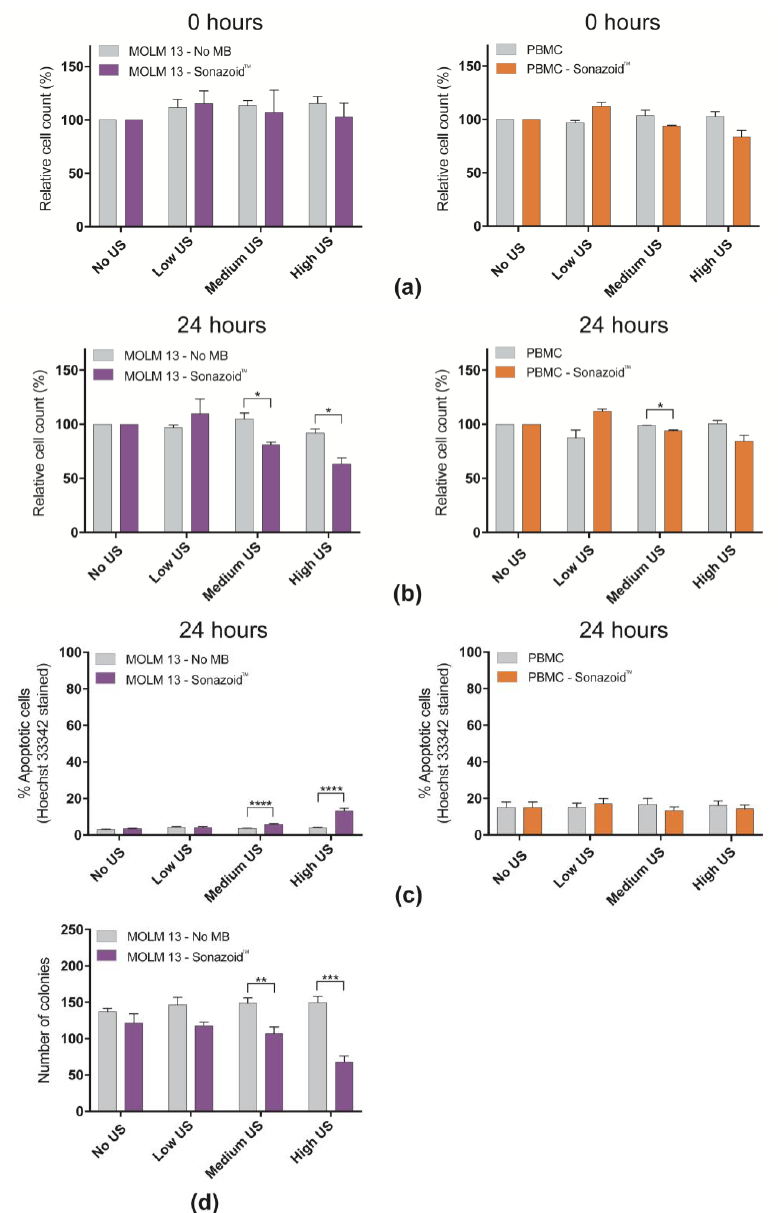
Figure 4. Viability of cells in response to ultrasound ± Sonazoid TM microbubbles ( a ) Normalized cell count at di ff erent ultrasound intensities ± Sonazoid TM microbubbles (normalized to cells not treated with ultrasound), of cells harvested immediately after sonoporation (0 h). No significant change in cell count due to sonoporation was observed ( b ) Normalized cell count of cells harvested 24 h after sonoporation. After 24 h the cell count was significantly lower in samples treated with medium ( p < 0.05) and high ( p < 0.05) ultrasound intensity. The cell count of PBMCs did not change much after 24 h in any of the samples. A small increase in cell count was observed in the samples treated with the lowest ultrasound intensity, but this e ff ect is not significant. A small, but significant, decrease in cell count was observed in the sample treated with medium ultrasound intensity. ( c ) Apoptotic cells 24 h post sonoporation by Hoechst 33342 staining in MOLM-13 and PBMC ( d ) Number of colonies of MOLM-13 formed post sonoporation (colony forming assay). * p < 0.05, ** p < 0.01, *** p < 0.001, **** p <